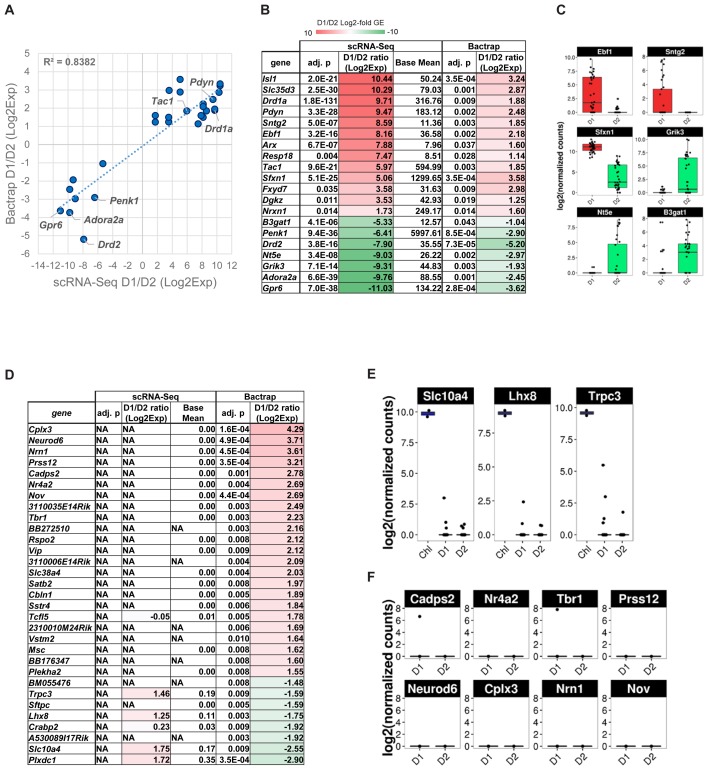
Gene expression specificity for MSN subtypes as measured by scRNA-Seq and compared to population-based gene expression data. BacTRAP data for this comparison was taken from Supplementary Table S2 by Heiman et al. (2008). (A) Scatter plot shows correlation for major MSN subtype-specific genes with adjusted p < 0.05 either for scRNA-Seq or BacTRAP. Notable examples are labeled. (B) Differential expression of major D1 and D2 MSN-specific genes commonly found by scRNA-Seq and reported by BacTRAP (adjusted p < 0.05). Genes displayed were found as statistically significant and with same specificity based on at least one microarray probe in the Heiman et al. (2008) data set. Genes are listed by differential expression from D1 MSN- (top, red) to D2 MSN-specific (bottom, green). (C) scRNA-Seq data of additional D1 and D2 MSN-specific markers identified by Heiman et al. (2008) using BacTRAP. (D) D1 and D2 MSN-specific gene expression patterns as identified by BacTRAP experiments that are not confirmed by scRNA-Seq. Genes with adjusted p < 0.01 based on BacTRAP are shown. For genes represented by several probes in the BacTRAP data, the adjusted p-value of the most significant probe is displayed. (E) Examples of reportedly D2 MSN-specific genes that are identified by scRNA-Seq as specific to striatal cholinergic interneurons. (F) Examples of reportedly D1 MSN-specific genes identified by scRNA-Seq as non-subtype-specific or not expressed in MSN.